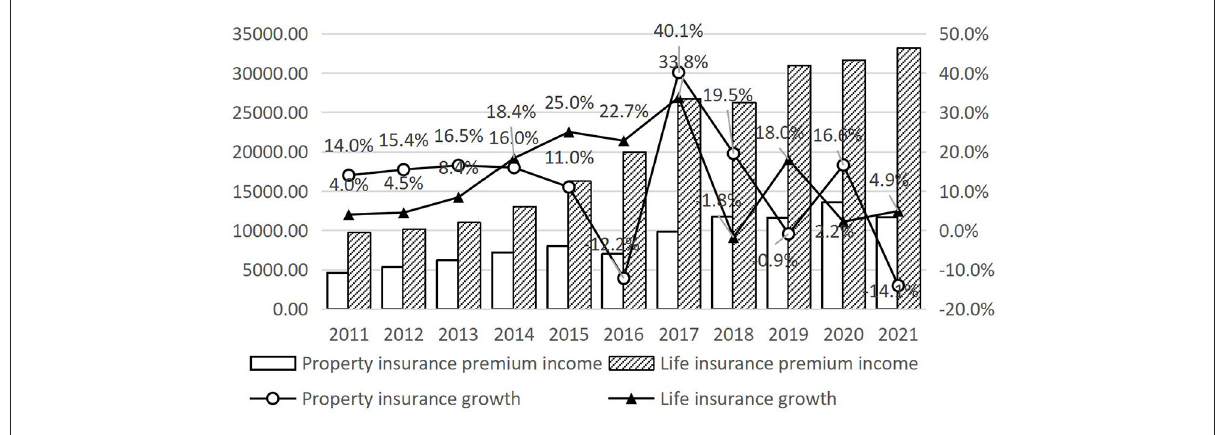
FIGURE1 Premium income and growth rate of Property and Life insurance in China from 2011 to 2021. Data source is the Insurance Industry Association of